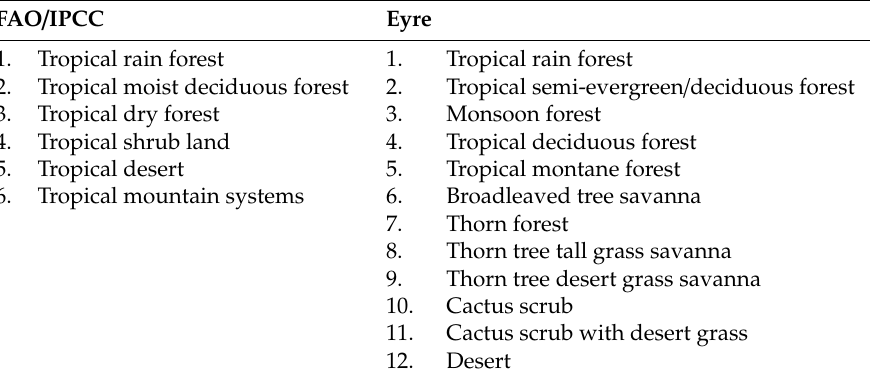
Table 2. Classifications of tropical biome types by the UN Food and Agriculture Organization (FAO) / Intergovernmental Panel on Climate Change (IPCC) [37,38] and Eyre [39].